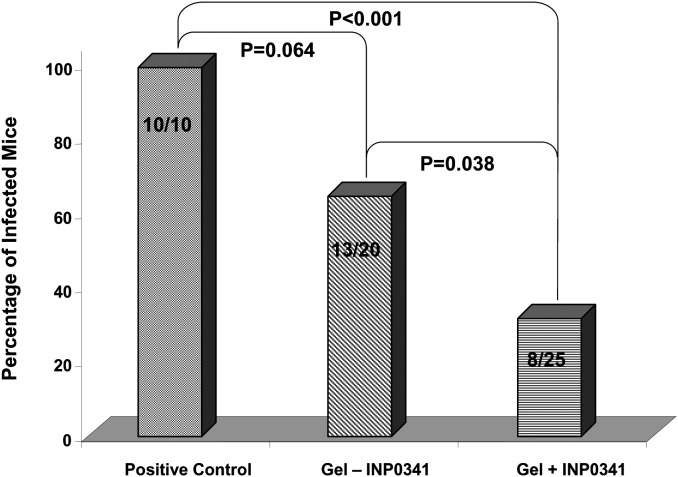
Comparison of the three treatment groups as to protection against a vaginal challenge with C. trachomatis.The overall mice culture positive over a month period in each treatment group after a vaginal inoculation with 500 IFU of C. trachomatis is shown. The positive control group was sham treated whereas the other two groups received the vaginal gel formulated with and without INP0341. The P values, as determined by the Fischer’s exact test, are shown comparing groups to one another. A P value <0.05 was considered statistically significant. The experiment was repeated with two sets of mice and the graph reflects the combined results of the two experiments.